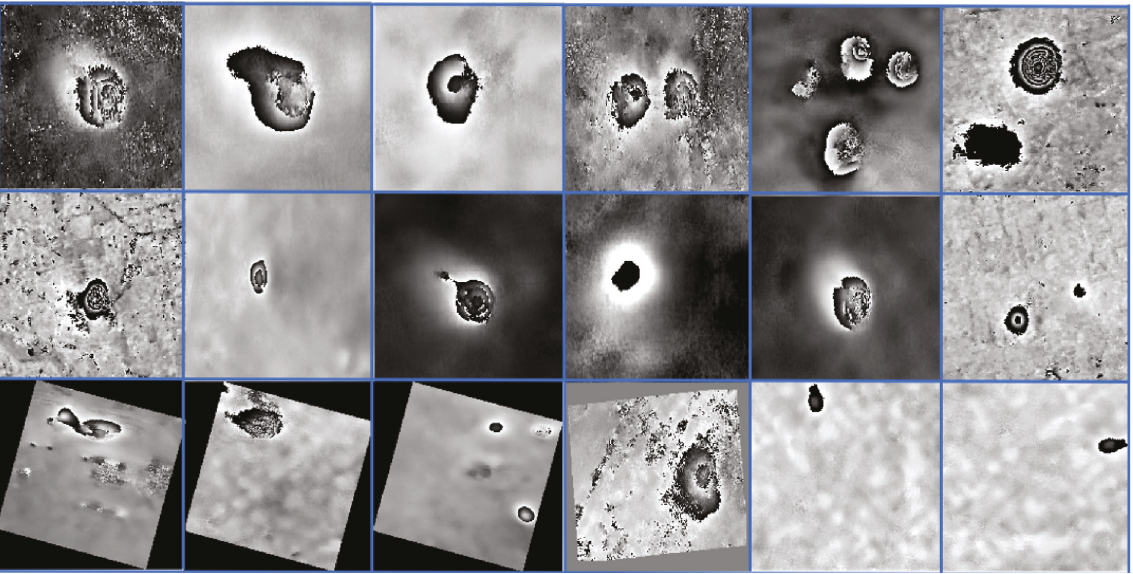
Figure 3: Partial sample datasets for training the CenterNet network.